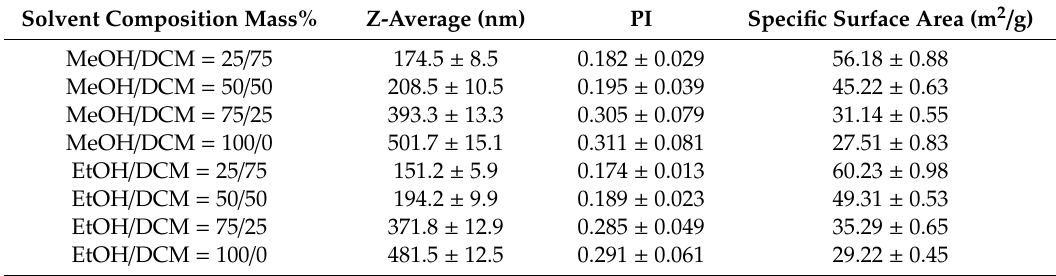
Table 1. Particle size (dynamic light scattering method, DLS) and specific surface area of trans